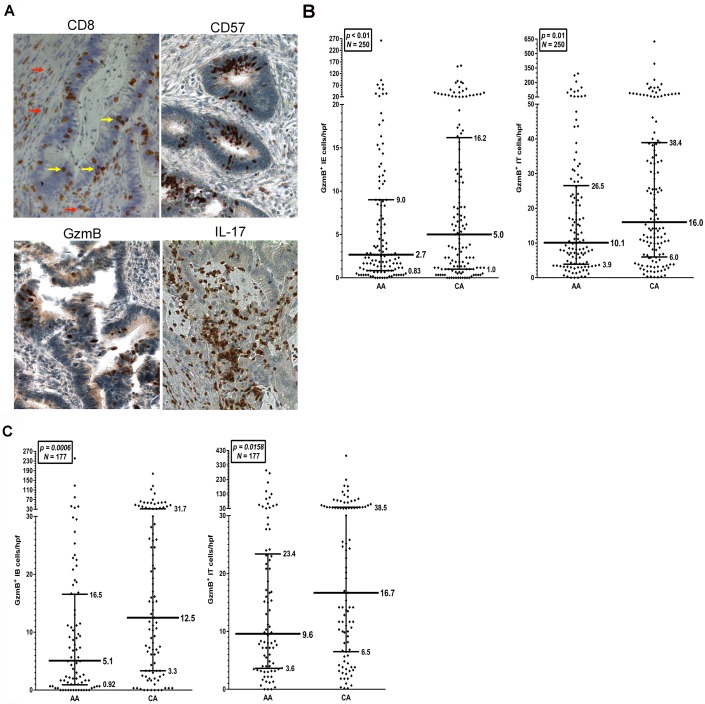
Presence of CD8+, CD57+, GzmB+ and IL-17+ cells in CRC.A) IHC staining of colon cancer samples from the NCCCS for the markers indicated. Red arrows indicate cells positive for CD8 in the stromal tissue while yellow arrows indicate staining of CD8+ cells in the epithelial tumor nests (IE staining). B) Distribution of GzmB+ cell infiltration in CRC samples. Dot plots of IE and IT GzmB+ infiltrating cells in the NCCCS samples stained by IHC. The median cell numbers are indicated with bold horizontal lines, with the interquartile ranges indicated in thinner lines. C) Distribution of GzmB+ cells at the IB. Dot plots of the IB and IT GzmB+ infiltrating cells in the NCCCS tumor samples from Fig 2A and 2B that contained an invasive margin.